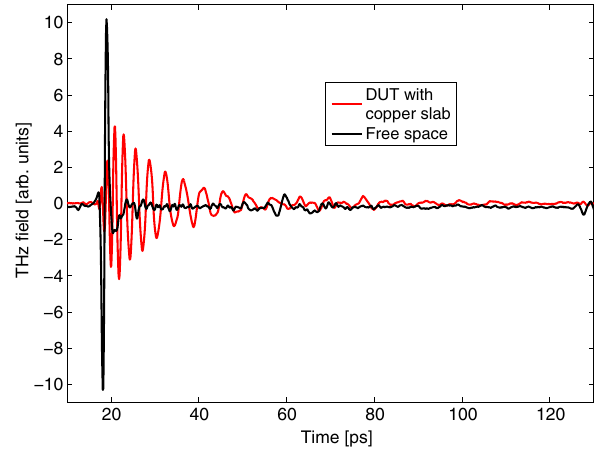
FIG. 12. THz time domain signal propagation in free space (black curve) and in the DUT (red